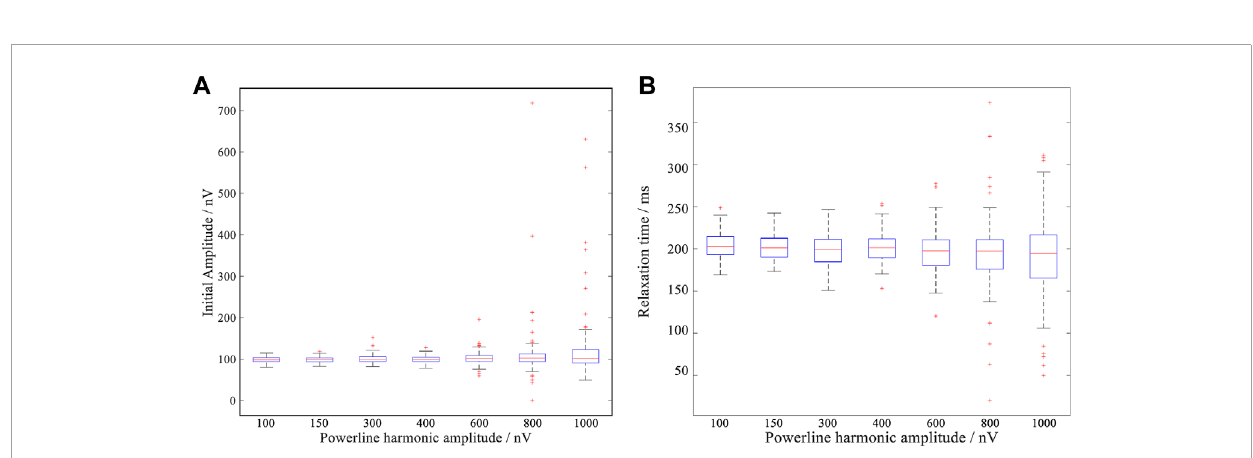
FIGURE 4 The fitting errors of related parameters under different power frequency harmonic amplitudes; (A) Box diagram of initial amplitude fitting values at different power frequency harmonic amplitudes; (B) Box plots of the fitting values of the mean relaxation time at different power frequency harmonic amplitudes.